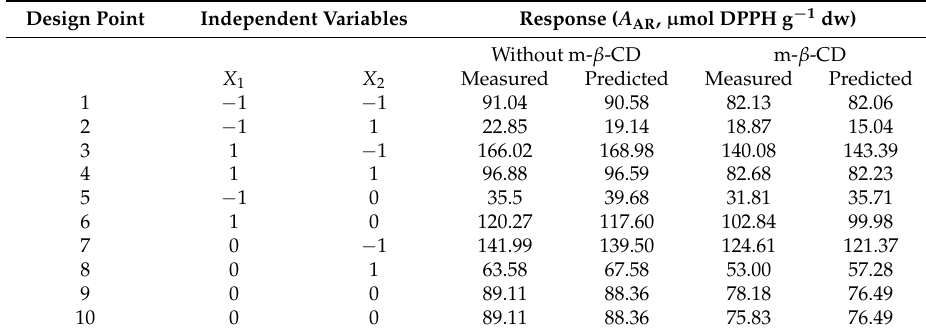
Table 2. Measured and predicted A AR values of OLL extract and AA mixtures, determined for individual design